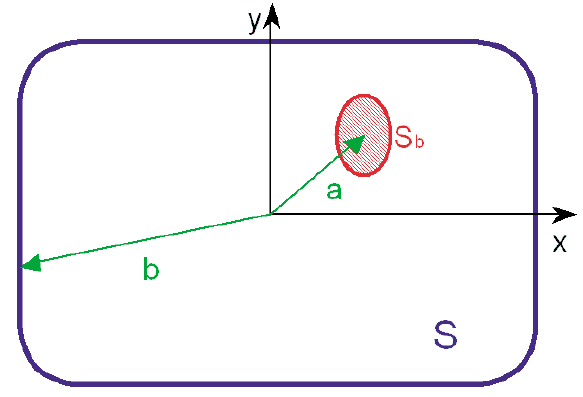
FIG. 1. (Color) Transverse cross section of the vacuum chamber S and of the beam S b